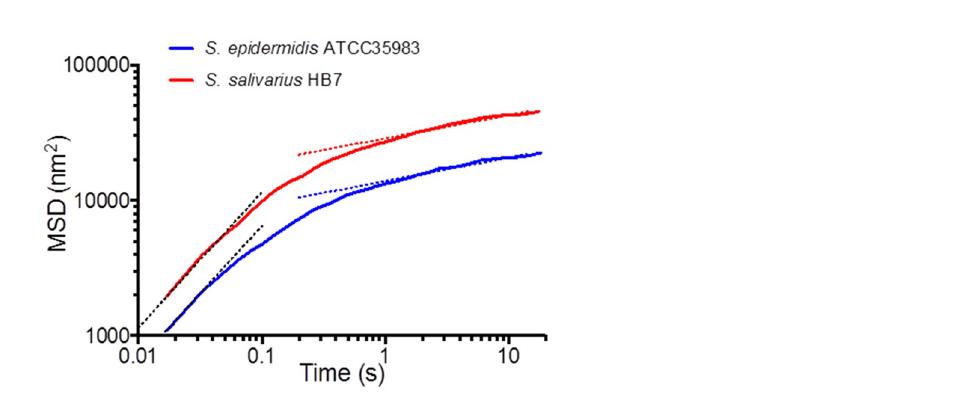
Figure 2. Time-resolved nanoscopic position-maps and autocorrelation functions of S. epidermidis ATCC35983 and S. aureus ATCC12600 adhering to a glass surface. ( A ) Time-resolved position map of S. epidermidis ATCC35983 adhering to a glass surface over a 33 s measuring period (bacterial positions indicated by grey dots), resolved into four time intervals of 0.17 s (equivalent to ten frames) with bacterial trajectories and positions indicated by colored lines and dots for the different intervals. ( B ) Same as panel A, now for S. aureus ATCC12600. ( C ) Autocorrelation as a function of time calculated over the entire 33 s measuring period from the x-positions of S. epidermidis ATCC35983 adhering to a glass surface (displayed only for the first 10 s of an experiment). ( D ) Same as panel ( C ), now for S. aureus ATCC12600.